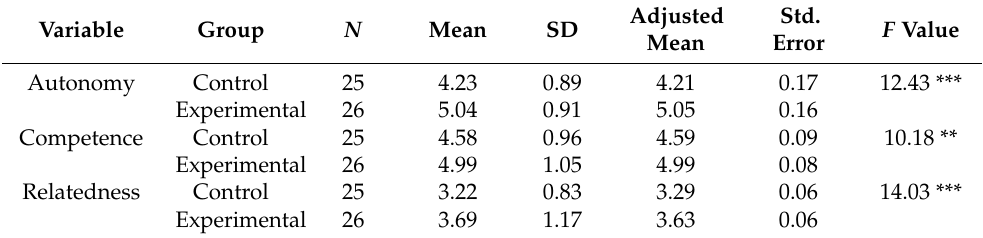
Table 2. ANCOVA of the post-test results for perceived